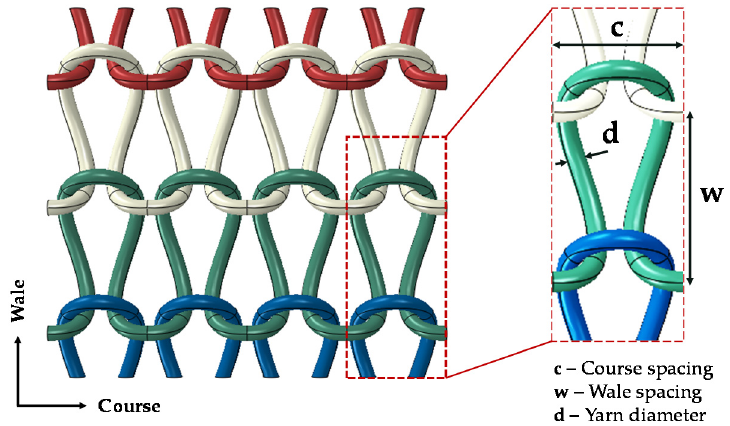
Figure 1. Knitting pattern of the plain weft-knitted fabric and its geometrical